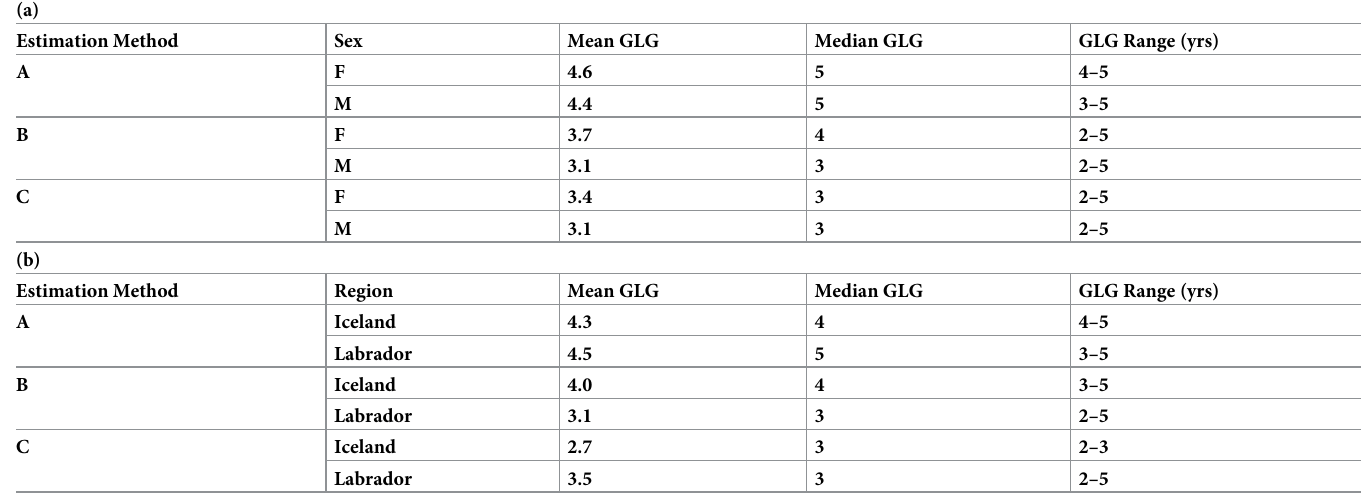
Table 4. Mean, median and range of weaning completion age for different estimation methods as described in the analyses, compared by (a) sex and (b)